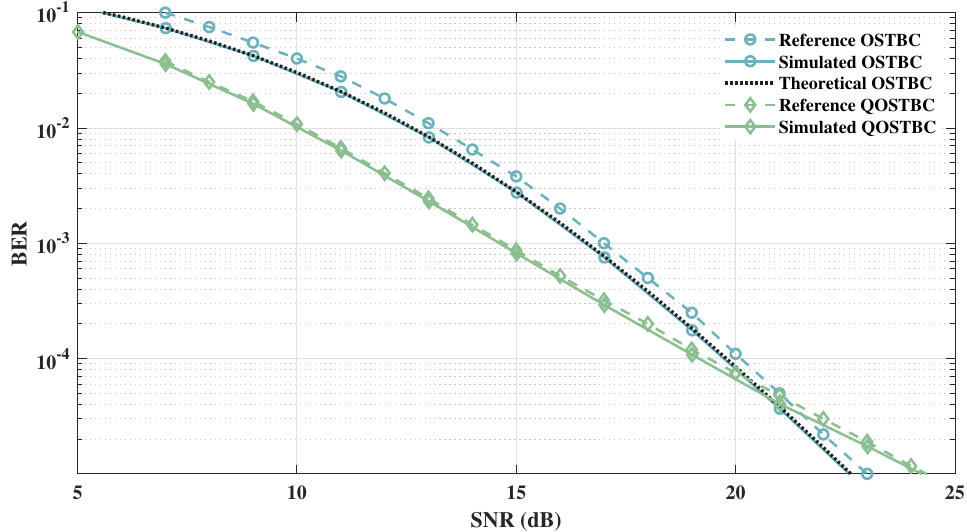
Figure 9. Simulated, reference, and theoretical results for equal diversity order and bitrate